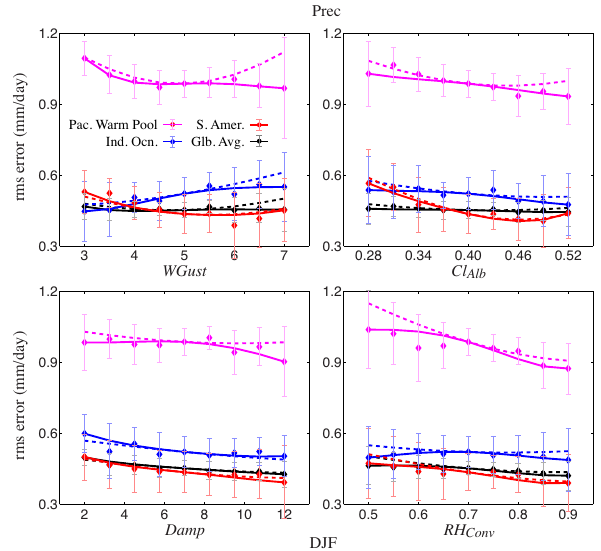
Fig. 4. Root-mean-square precipitation error of the modeled regres- sion coefficients for the El Niño 3.4 index in December–February in blue, March–May in magenta, June–August in red, and September– November in black, relative to the CPC Merged Analysis of Precip- itation data set. The AGCM values are compared to the quadratic metamodel reconstruction based on the endpoints for each param- eter, and to its linear counterpart. Units on abscissa are ms − 1 for WGust, days for Damp and nondimensional for Cl Alb and RH Conv . Error bars quantify the spread of the RMS error in the ten ensemble members ( ± 1 standard error of the